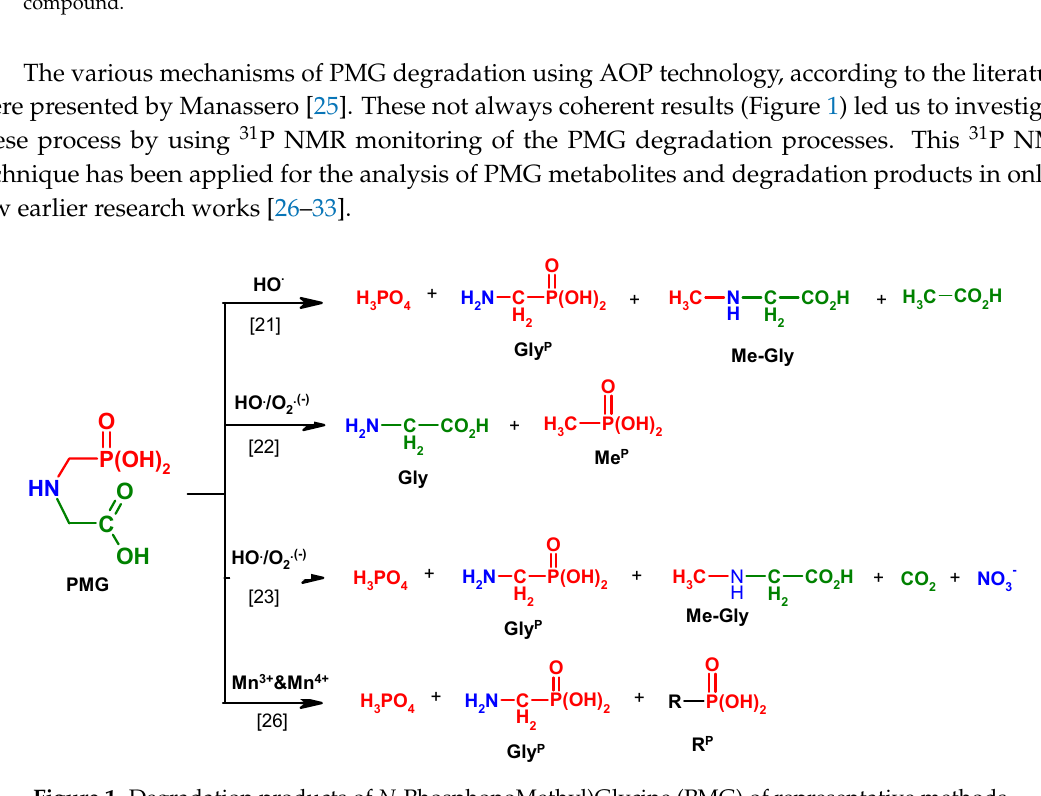
Figure 1. Degradation products of N -PhosphonoMethyl)Glycine (PMG) of representative